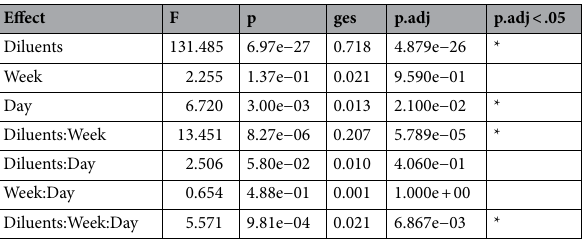
Table 1. Results of the three-way mixed ANOVA. ges = generalized eta